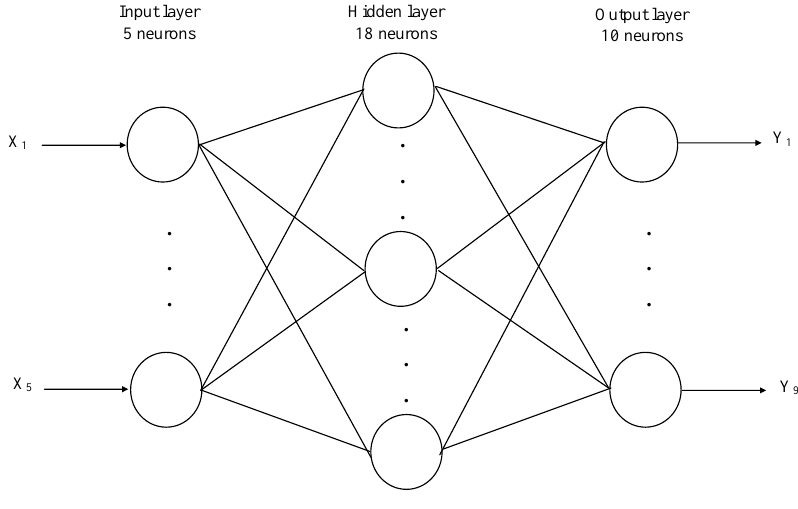
Figure 4. Structure of the optimal ANN.